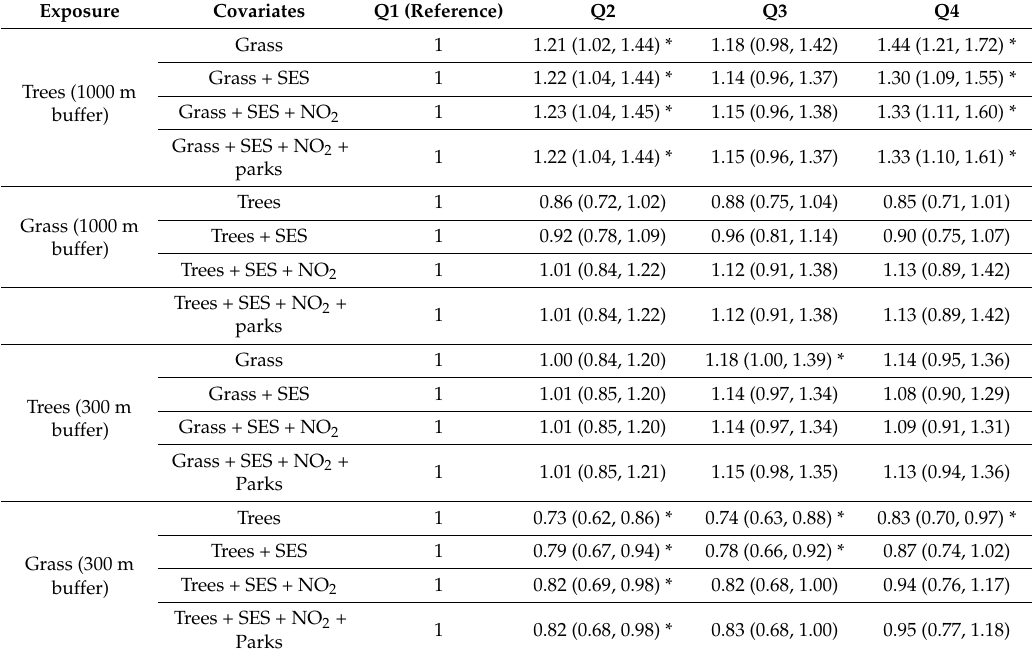
Table 4. RRs for self-reported “very good” or “excellent” health by quartiles of simultaneously-adjusted trees or